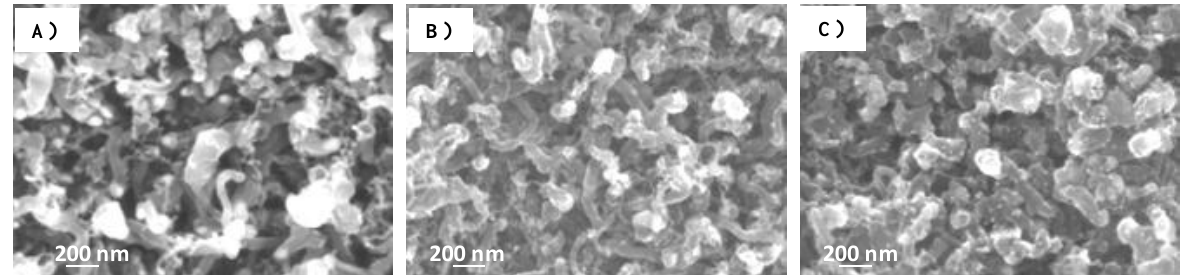
Figure 4. SEM images of (a) pristine CNTs, and CNTs with (b) 0.3at.% and (c) 1.1at.% Au loading.